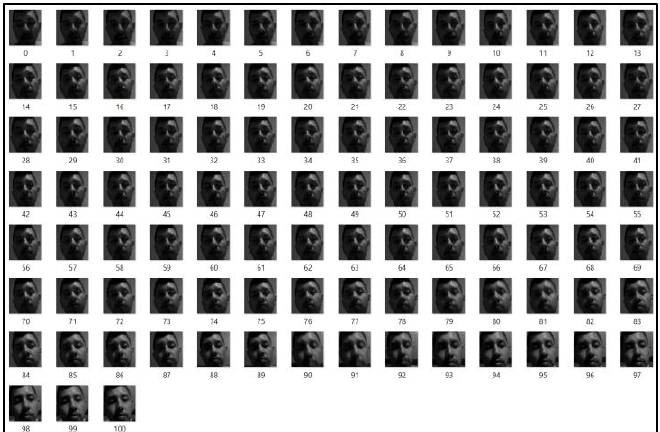
Figure 34: Folder with frames from user 1 with low